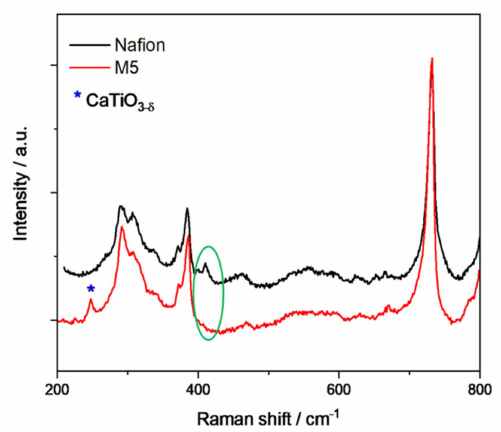
Figure 5. Raman spectra of a M5 membrane compared to Nafion membrane.